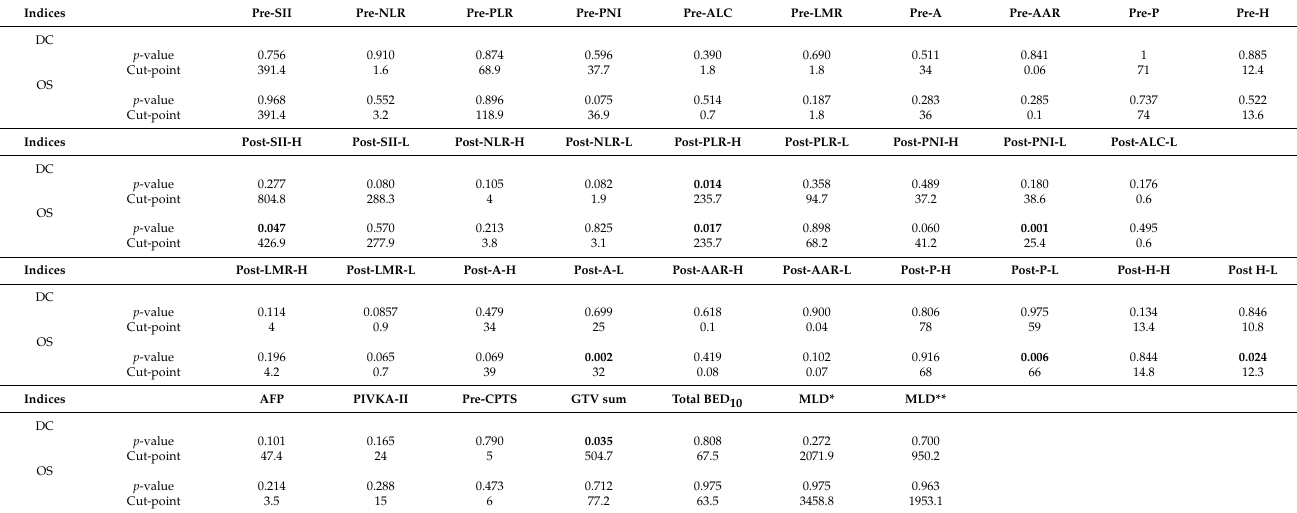
Table 4. Optimal cutoff points of variables for major study end points.